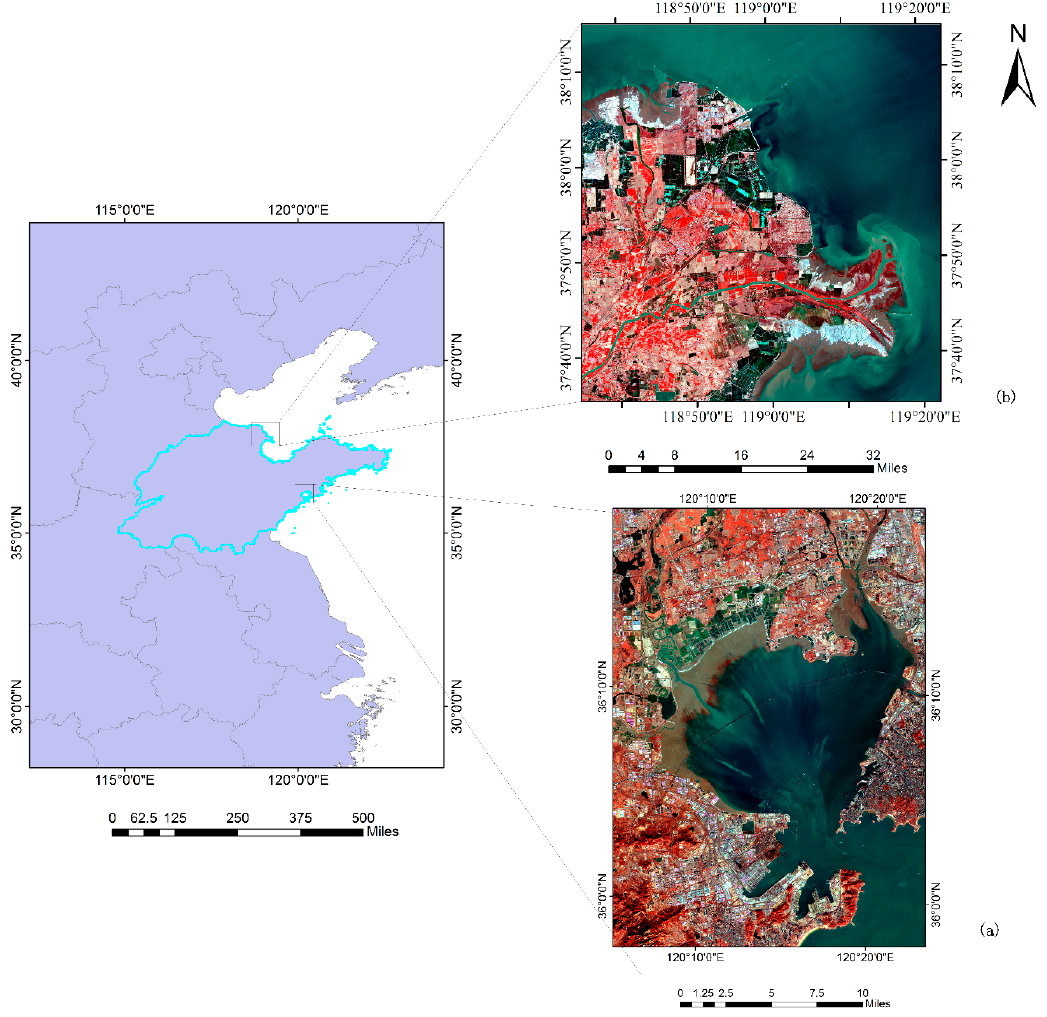
Figure 6. The study areas: ( a ) Jiaozhou Bay wetland and ( b ) Yellow River Delta (YRD) wetland (satellite images from Sentinel-2 are shown in false color red–green–blue (RGB) = near-infrared (NIR)– red–green).